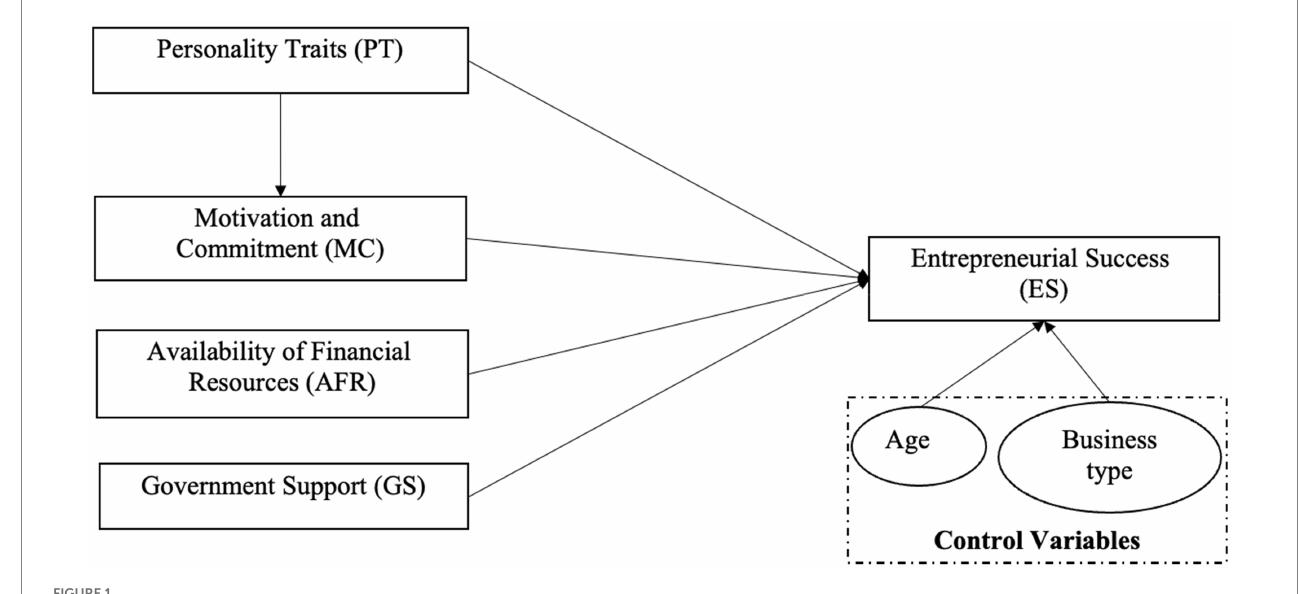
FIGURE 1 Theoretical